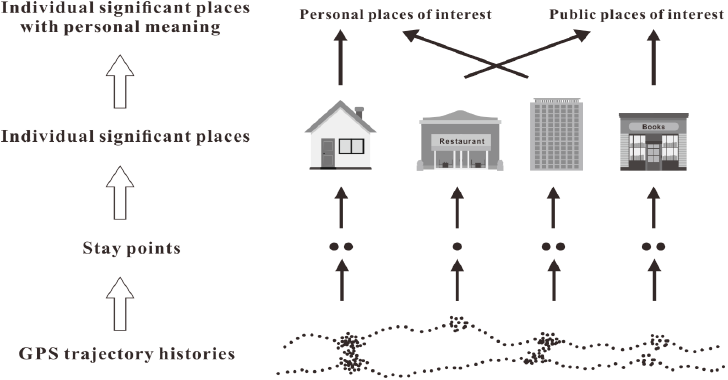
Figure 2. Identifying individual significant places with personal meaning using a four-layered